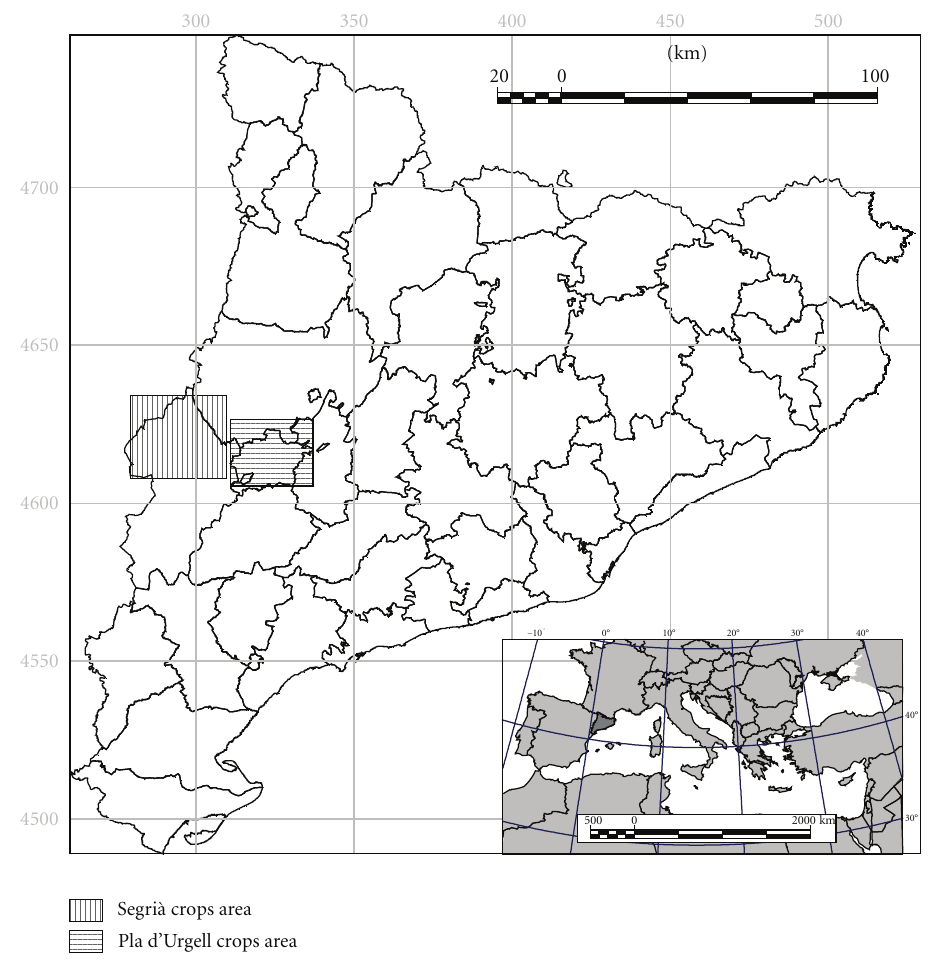
Figure 2: Zones used in the study located in Catalonia (northeast Spain). Two zones were selected: Segri`a and Pla d’Urgell.